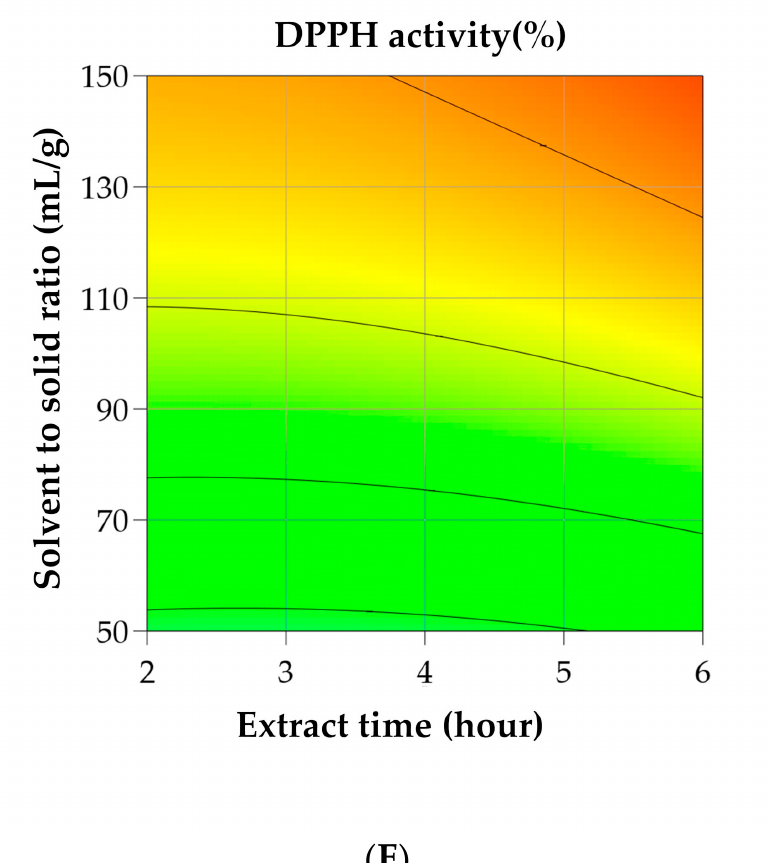
Figure 5. Response surface and contour plots exhibit the effect of hydrothermal extraction temperature, time, and solvent-to-solid ratio on the DPPH activities of Acer tegmentosum . ( A/B ) Effect of extraction temperature and time on DPPH activities as ( A ) a 3D response surface graph and ( B ) a contour plot. ( C/D ) Effect of extraction temperature and solvent-to-solid ratio on DPPH activities as ( C ) a 3D response surface graph and ( D ) a contour plot. ( E/F ) Effect of extraction time and solvent-to-solid ratio on DPPH activities as ( E ) a 3D response surface graph and ( F ) a contour plot.